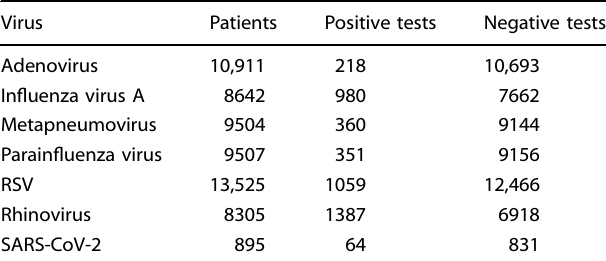
Table 2. Total number of patients and number of positive and negative test results used to develop models for each virus